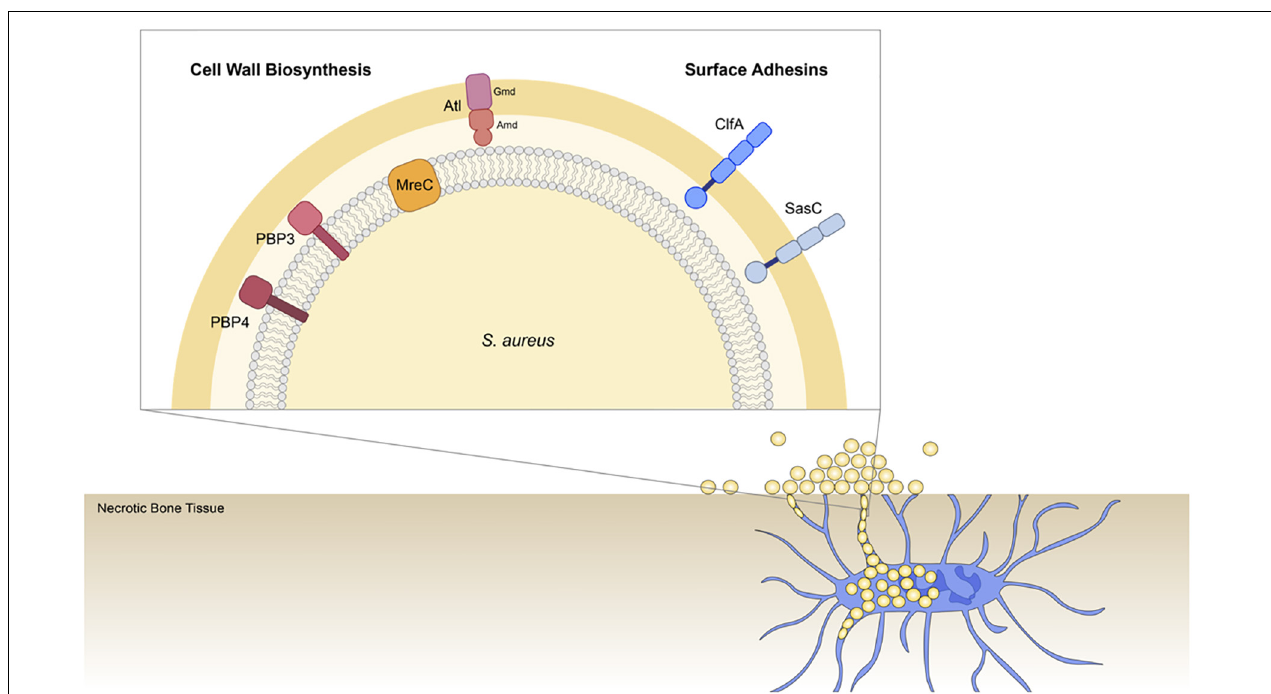
FIGURE 1 | Illustration of Staphylococcus aureus genes investigated for their role in osteocyte lacuno-canalicular network (OLCN) invasion during osteomyelitis. To expand our understanding of S. aureus deep bone infection, this work investigated selected cell wall biosynthesis proteins and surface adhesins. Previous studies identified PBP4 as a critical factor of S. aureus OLCN invasion in vivo (Masters et al., 2020). Here we investigated the non-essential transpeptidase, penicillin binding protein 3 (PBP3; Pinho et al., 2000); proposed morphogenetic determinant protein, cell shape-determining protein MreC (MreC) (Divakaruni et al., 2007); major peptidoglycan hydrolase, Autolysin (Atl), which is composed of Amd and Gmd subunits (Vollmer et al., 2008); cell wall-anchored and fibrin binding protein, clumping factor A (ClfA) (McDevitt et al., 1994); and cell wall-anchored protein involved in biofilm formation, surface protein C (SasC; Zhu et al.,